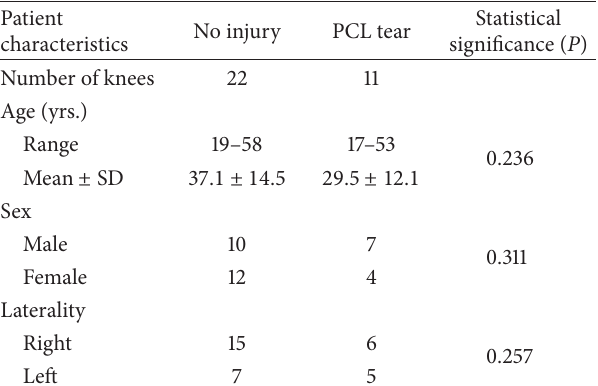
Table 1: Group demographics